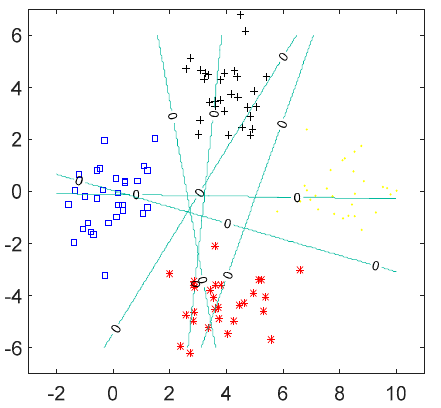
Figure 17. Visual model of the SVM quadclassifier.